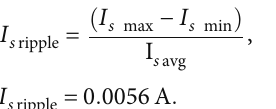
I I , and I of the PV system- s , dc1 dc2